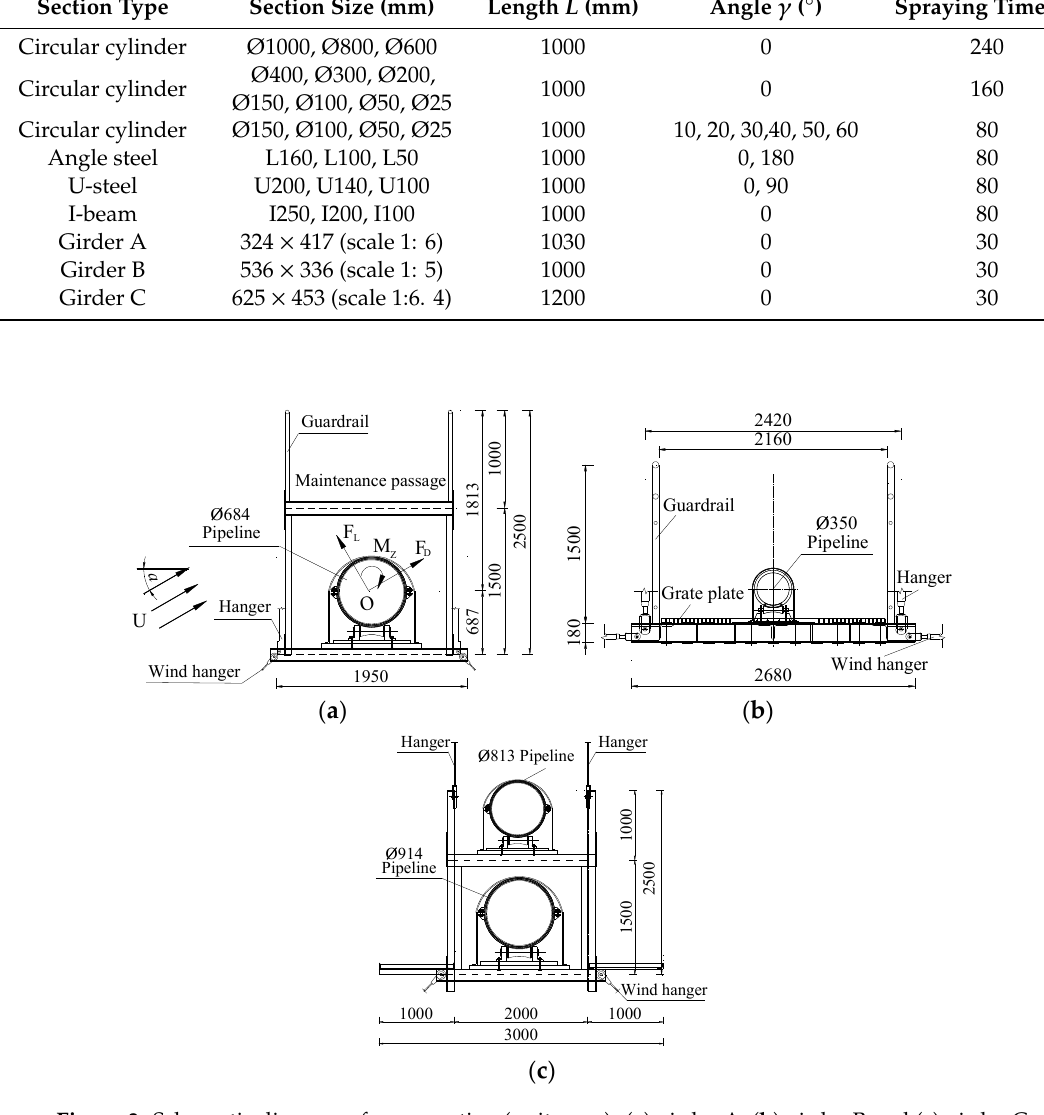
Figure 3. Schematic diagram of cross section (unit: mm): ( a ) girder A, ( b ) girder B and ( c ) girder C.